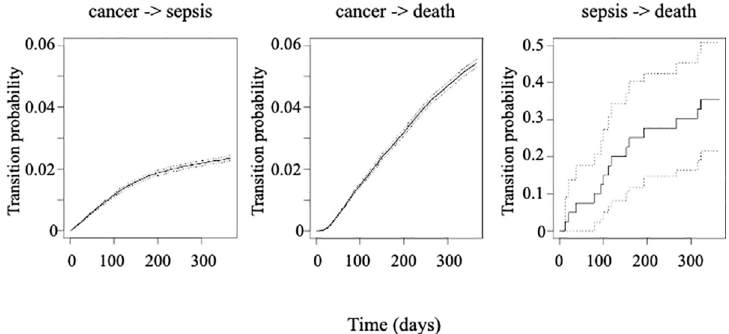
Fig 3. Transition probabilities within the first year after cancer diagnosis between the states « cancer », « sepsis » and « death » based on the multistate model. Dark lines represent for a patient diagnosed with cancer at day 0 the probability of transitioning from one state to another over time; grey dotted lines represent the 95% confidence intervals. Cancer- > death represents the transition from cancer to death without sepsis.